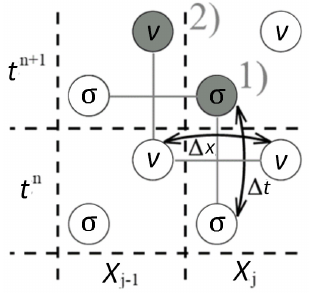
Figure 2. The staggered discretization of field variables velocity v and stress σ in the elastodynamic finite integration technique (EFIT).